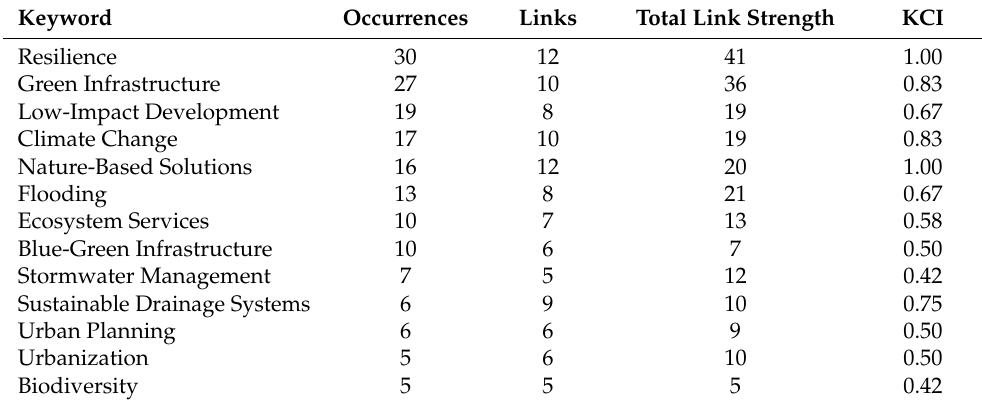
Table 5. The 13 keywords, representing topics of interest, used in at least five documents.